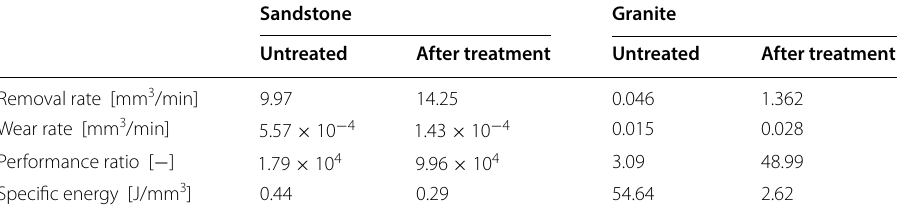
Table 1 Summary of rock removal performance parameters. Rock removal performance parameters for Rorschach sandstone (left) and Grimsel granite (right), evaluated under untreated and after-treatment material